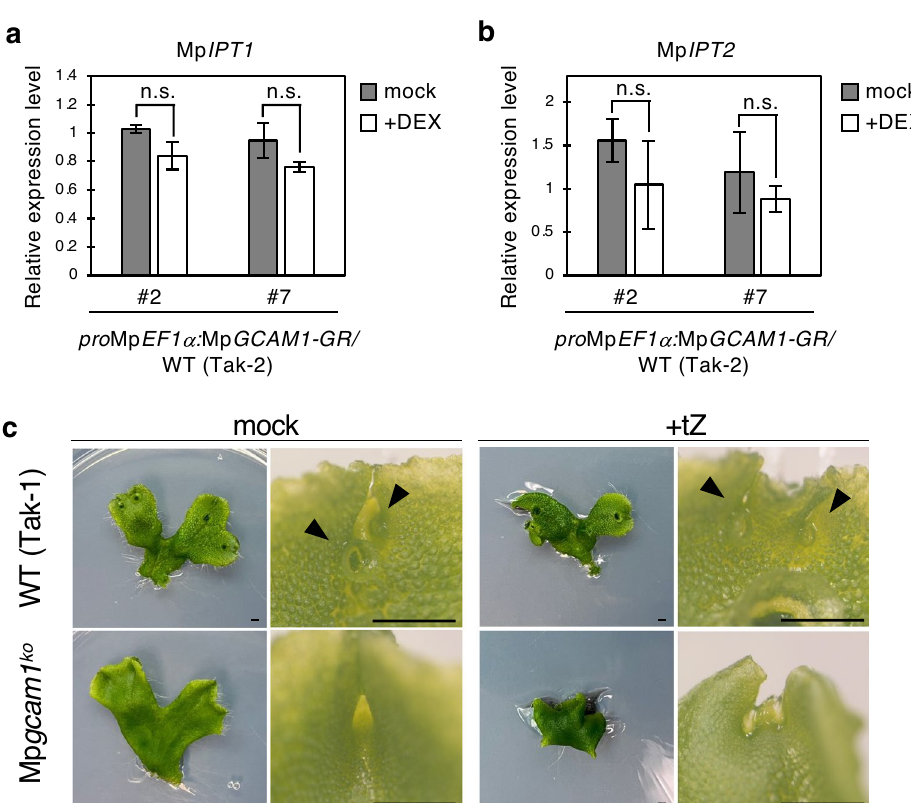
Figure 6. Mp IPT transcript levels in Mp GCAM1 -overexpressing plants and Mp gcam1 knockout lines grown in the presence of tZ. ( a,b ) Transcript levels of Mp IPT1 ( a ) and Mp IPT2 ( b ) in plants overexpressing Mp GCAM1-GR , which were treated with or without 10 µM DEX for 2 h. mRNA levels were normalized to that of Mp EF1α . Data are presented as mean ± SD ( n = 3). Significant differences from the plants with mock treatment were determined by Student’s t-test. n.s. not significant. ( c ) Thallus apices of the wild-type (Tak-1) and Mp gcam1 were treated with (+ tZ) or without (mock) 50 µM tZ for 14 days. The right panels are magnified images of apical notches. Arrowheads indicate gemma cups. Bars represent 2